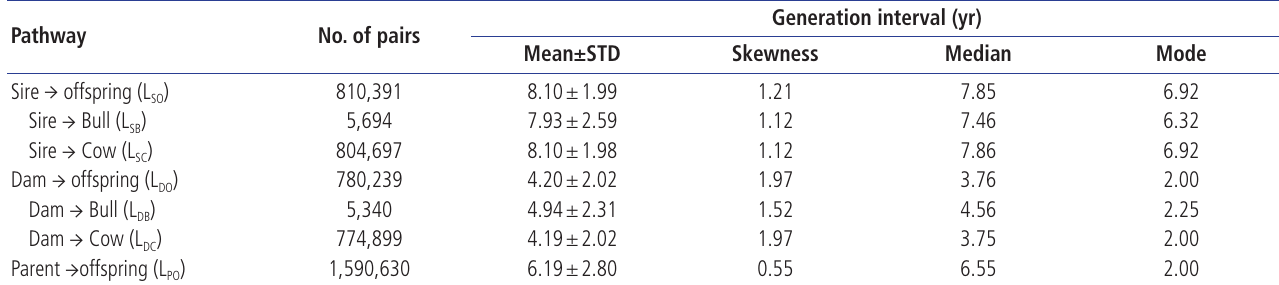
Table 1. Generation intervals in Holstein dairy cattle population Generation interval (yr) Pathway No. of pairs Mean±STD Skewness Median Mode Sire → offspring (L ) 810,391 SO Sire → Bull (L ) SB Dam → offspring (L ) DO Dam → Cow (L ) DC STD, standard deviation; Lso, generation interval from sire to offspring, etc. Table 2. Heritabilities, standard errors, genetic and phenotypic correlations among between parities for milk production traits in a Korean Holstein cattle population Milk production traits (kg) Parity Milk Fat Protein